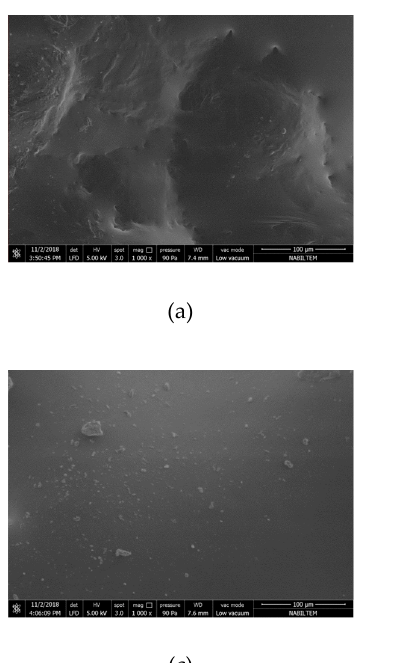
Figure 8. SEM (Scanning Electron Microscope) images of persimmon with 7 mm: ( a ) dried persimmon at 120 W; ( b ) dried persimmon at 350 W; ( c ) dried persimmon at 460 W; ( d ) dried persimmon at 600 W.